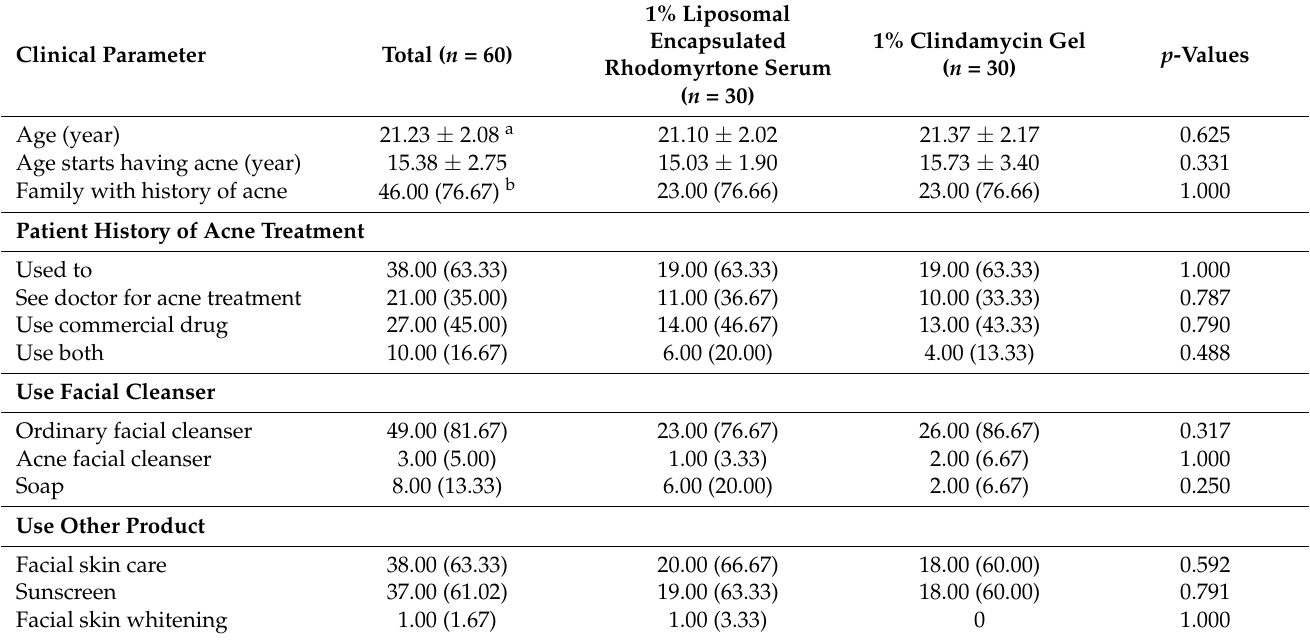
Table 1. Baseline volunteer characteristics.